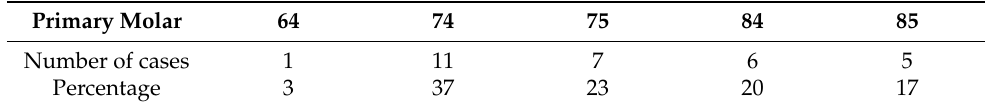
Table 4. Number of ankylosis cases on each primary